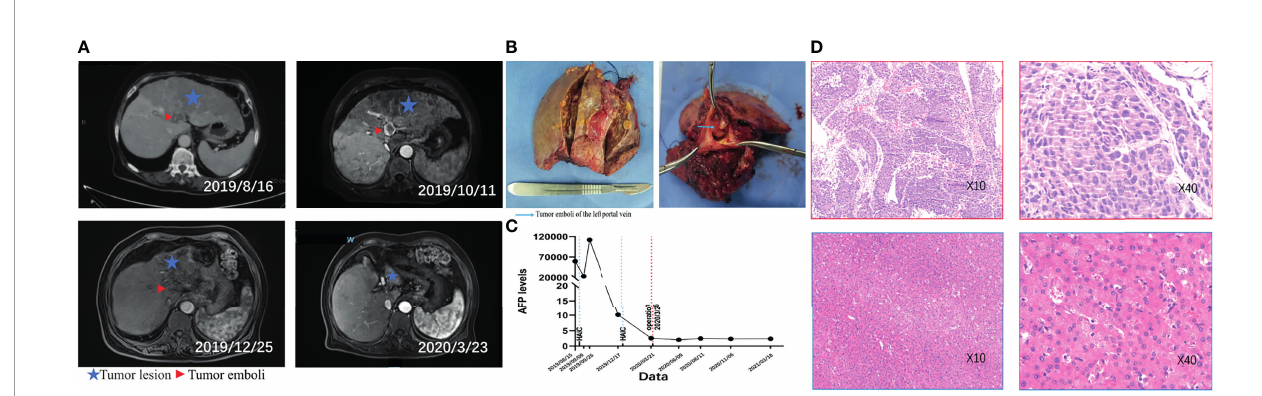
FIGURE 4 | Representative MRI images, AFP levels and pathological fi ndings highlighting changes before and after treatment in one patient. The patient was diagnosed with unresectable HCC in August 2019 and began triple combination therapy. First HAIC was performed on August 27, 2019, and the patient had endoscopic haemostasis for gastrointestinal bleeding (grade 3) that delayed the subsequent HAIC treatment. A second round of HAIC was performed on December 31, 2019, and the patients underwent surgery on March 26, 2020. Preoperative imaging evaluation showed a partial response, and postoperative pathology showed a pathologic complete response. (A) Imaging changes before and after treatment (comparison of tumor size at different times was marked by the sagittal segment of the portal vein. Aftertreatment, the volume of the left lobe of the liver was signi fi cantly reduced, and the right lobe was compensated); (B) intraoperative gross pathological specimen (left), transverse section of left portal vein (right); (C) change of AFP levels over time; (D) preoperative diagnostic pathological picture (above), postoperative pathological picture